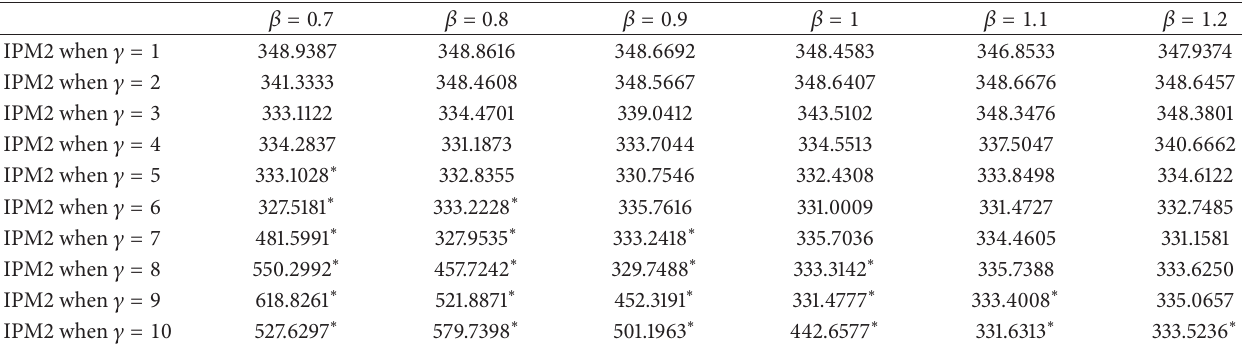
Table 4: Prediction errors of the new improved parsimonious multivariate Markov chain model with the new convergence condition of the new variability in sales demand